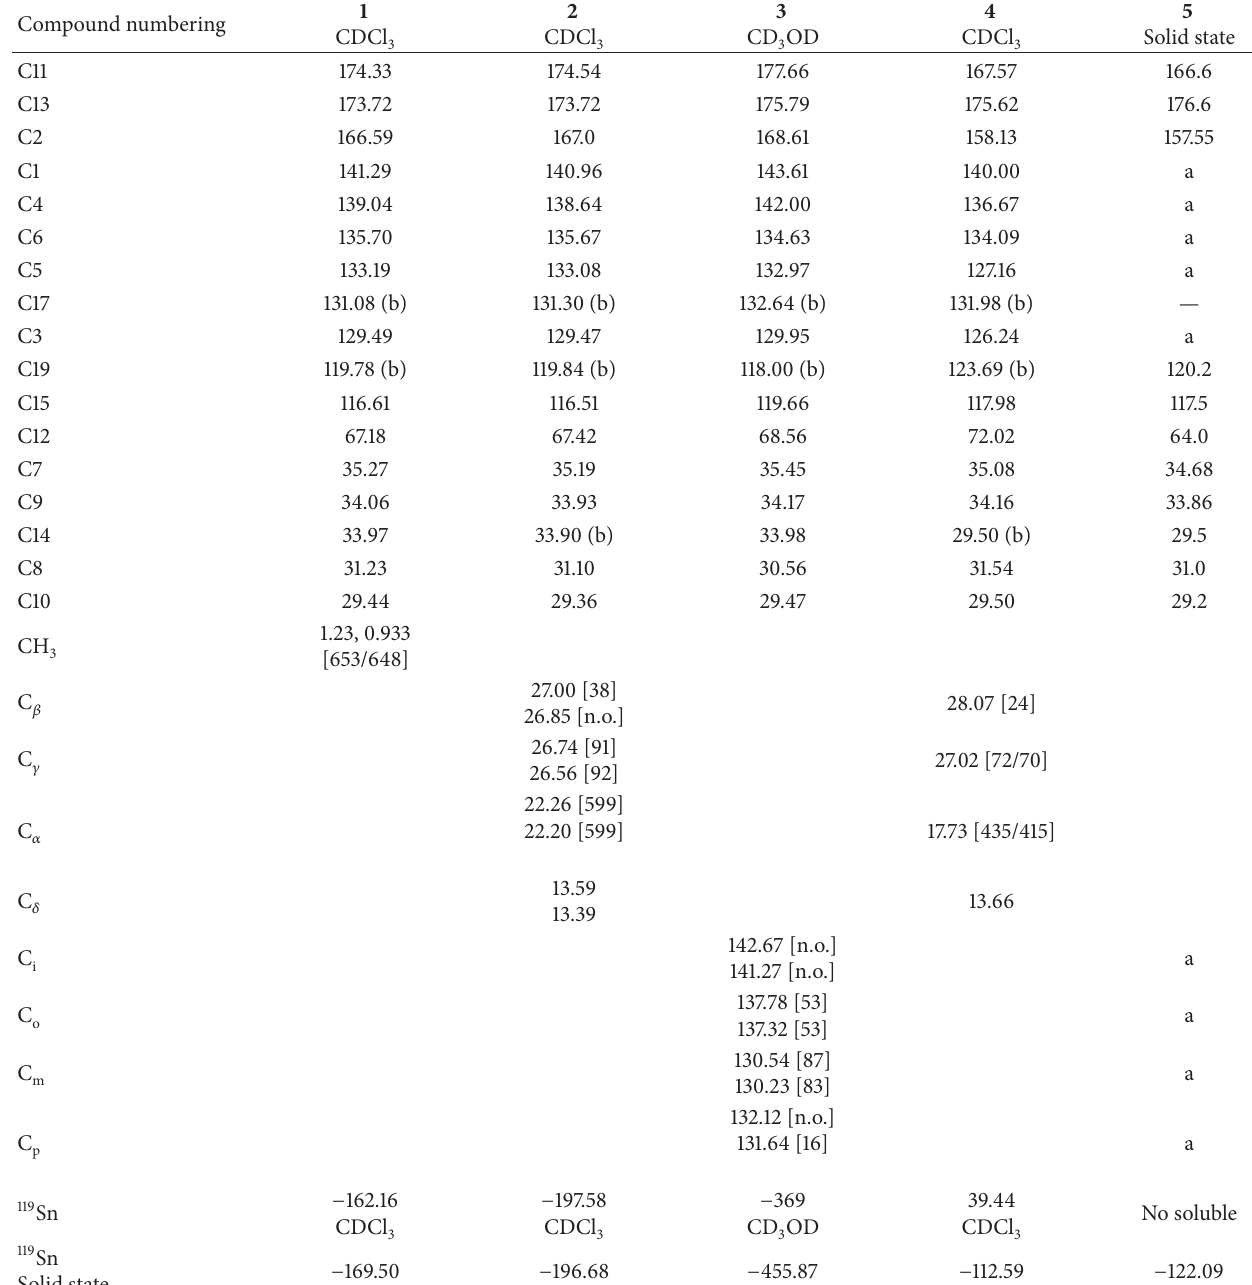
Table 2: 13 C and 119 Sn NMR data of compounds 1 – 5